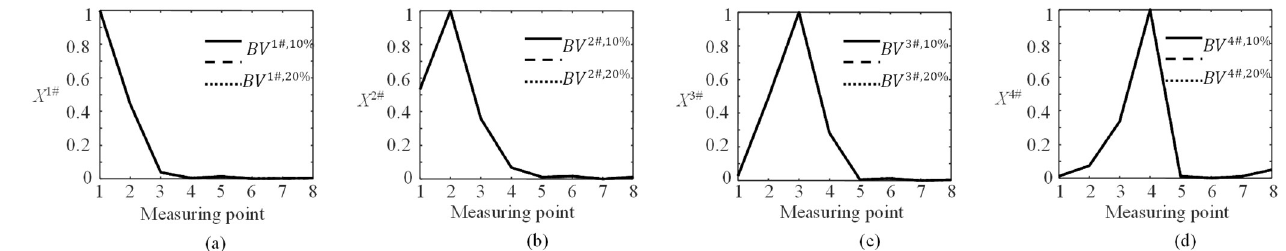
Figure 11. The poly line diagrams of BV j #, de for Cables 1#–4# with 10%, 20%, and 30% damage, respectively. ( a ) Cable 1#; ( b ) Cable 2#; ( c ) Cable 3#; ( d ) Cable 4#.